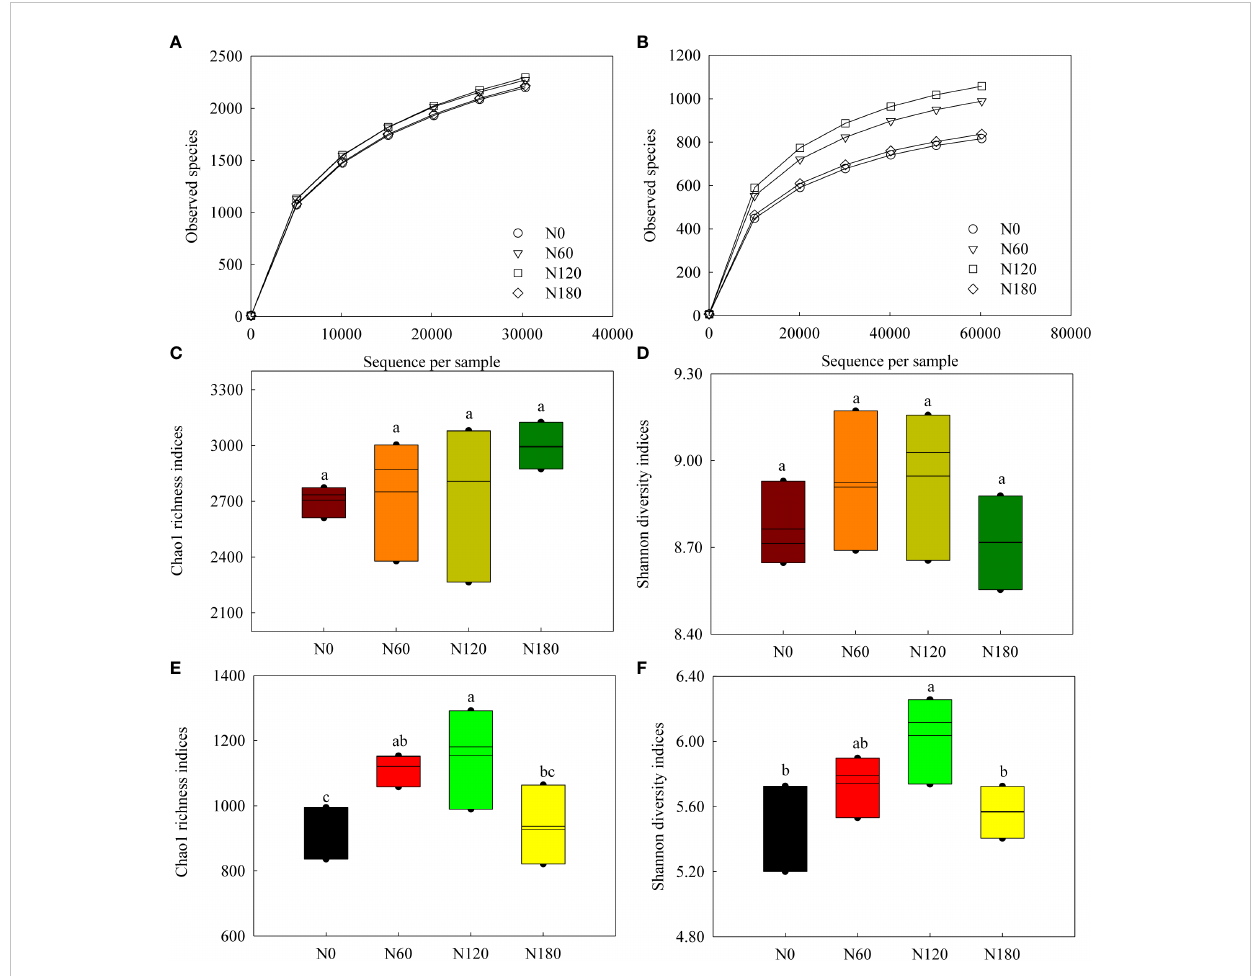
FIGURE 1 Rarefaction curves based on the observed species (A, B) , Chao1 richness (C, E) and Shannon diversity (D, F) indices of soil bacterial and fungal communities. Different lowercase letters denote the difference among the N levels at P <0.05, ANOVA (±SE, n